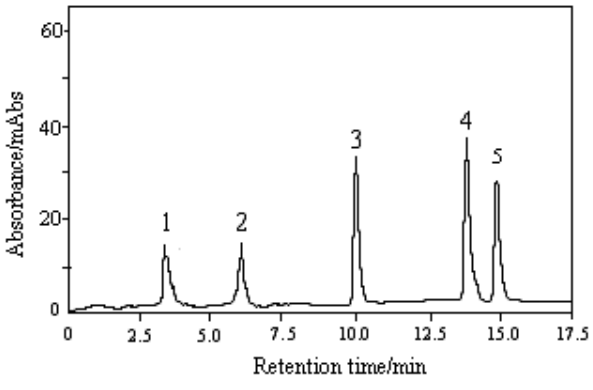
Table 1. The values of t